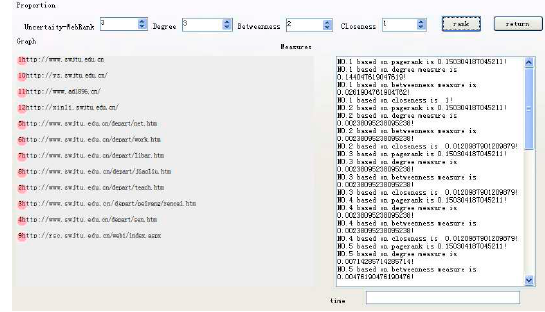
Fig. 2. Scenario of the WebMiner